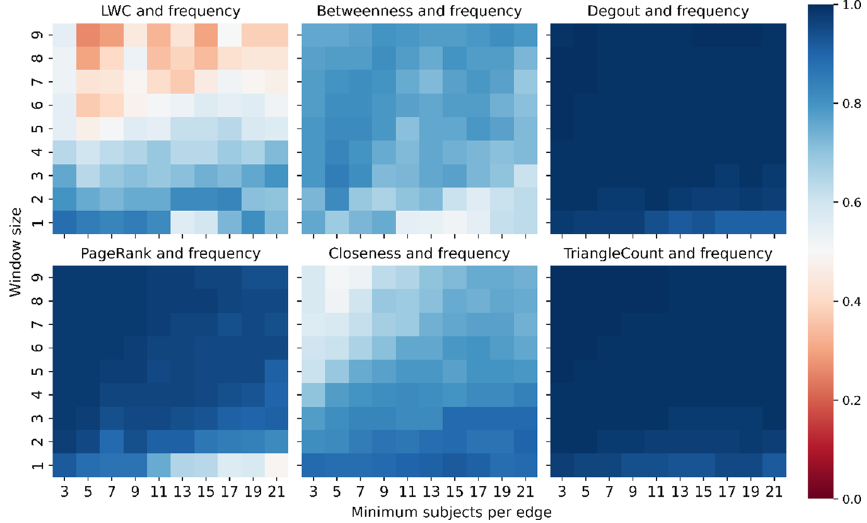
Fig. 7 Correlation matrices between a centrality measure and log frequency. Each plot represents a correlation matrix between a centrality measure and log frequency. The x-axis denotes the range of MS values, and the y-axis denotes the range of WS values. The color highlights the sign and magnitude of Spearman coefficients. The redder a cell is, the closer the correlation is to zero . The bluer a cell is, the closer the correlation is to